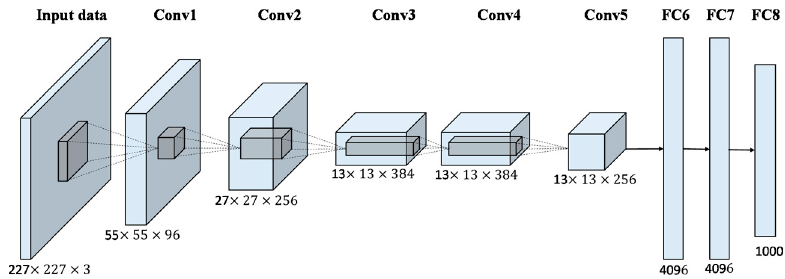
Figure 1. The AlexNet architecture.